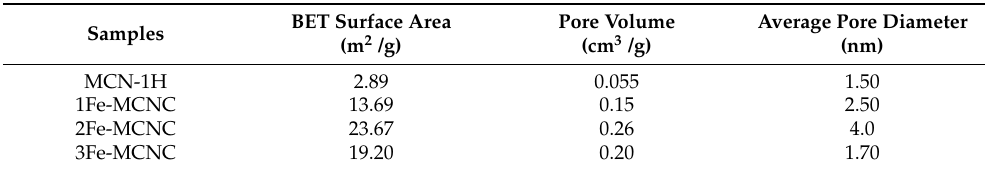
Table 2. BET analysis results of the surface area, pore volume, and average pore diameter of the MCN and Fe-MCNC nanostructures.